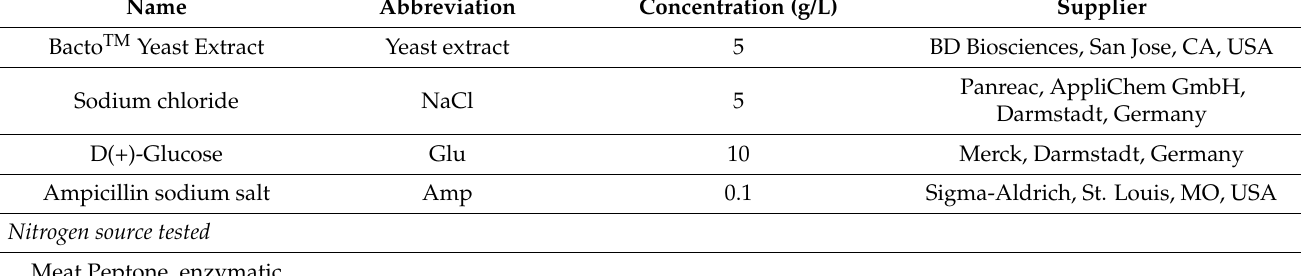
Table 3. Identification of the compounds, including the different peptones, used in the growth medium of E. coli TB-1.